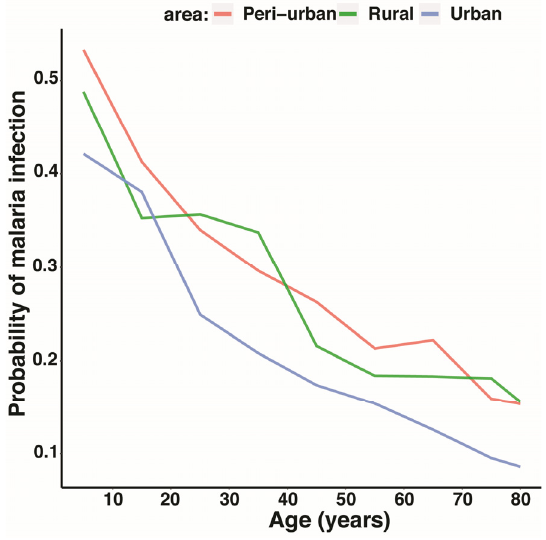
Figure 3. Predicted probability of malaria infection from the final logistic regression model. Table 3. Distribution of gametocytes amongst the study participants by age and area category.